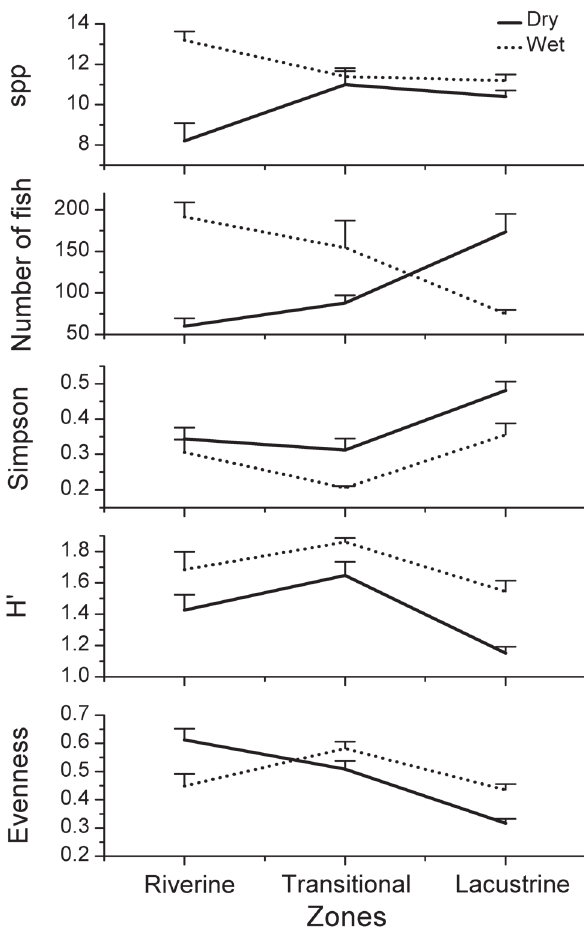
Figure 4. Average values and standard error (vertical lines) of rich- ness (spp), number of fish, Dominance, Shannon diversity (H’) and Evenness by zones and